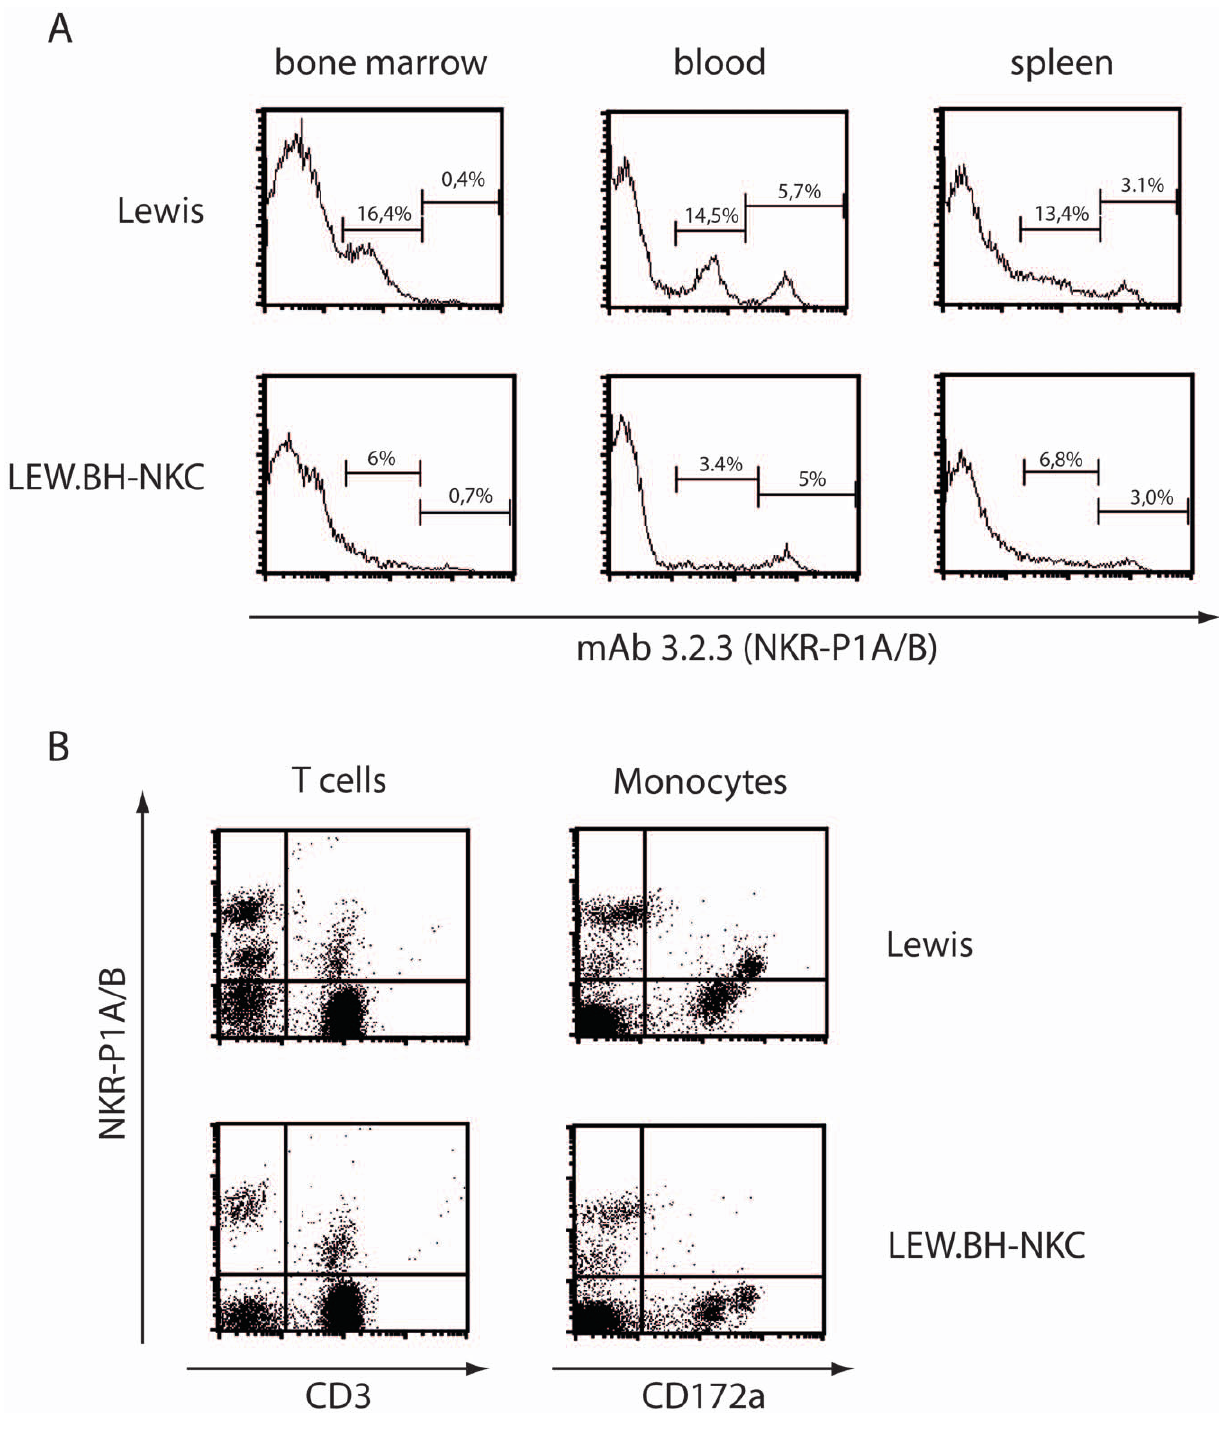
Figure 1. In congenic LEW.BH-NKC the monoclonal antibody 3.2.3 binds to NKR-P1A but not NKR-P1B molecules and allows clear identification of NK cells. A: Staining of Lewis wt and congenic LEW.BH-NKC bone marrow, blood derived lymphocytes and splenocytes with mAb 3.2.3 led to different recognition pattern in flow cytometry. While cells from Lewis wt showed two peaks indicating the detection two cell populations 3.2.3 high and 3.2.3 low , congenic LEW.BH-NKC derived cells revealed a comparable percentage of 3.2.3 high cells but an extenuated peak of 3.2.3 low cells. B: Double staining of mAb 3.2.3 with anti-CD3 and anti-CD172a, a marker for monocytes, respectively. While the 3.2.3 high expressing cells remain single positive the cells expressing 3.2.3 low were either double positive for CD3 thus can be designated as NKT cells or expressed on CD172a + monocytes. The 3.2.3 + /CD3 + could be also detected in LEW.BH-NKC rats whereas the CD172a + double positive cells were missing. These data indicate that the 3.2.3 high cells are NKR-P1A + NK cells and the 3.2.3 low cells comprise NKR-P1B expressing monocytes or NKT cells. Results are shown as representative data of a typical screen of Lewis wt and LEW.BH-NKC rats.